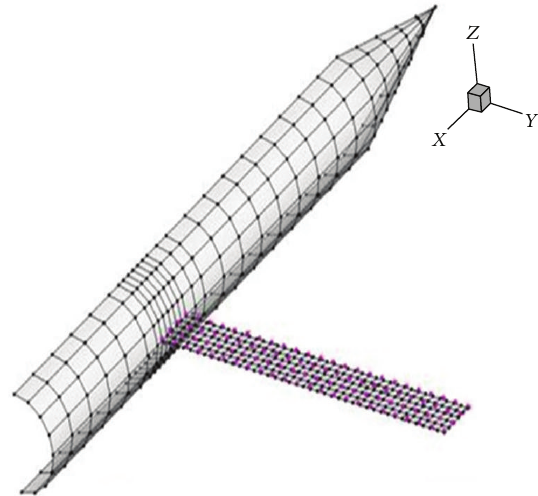
Figure 3: Aeroelastic model of the rectangular plate.